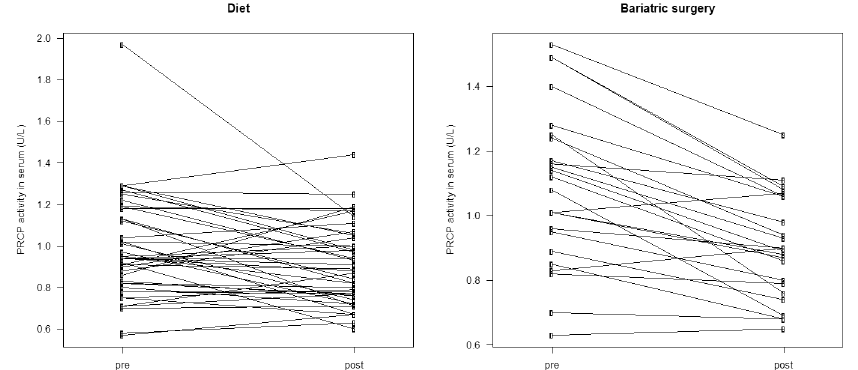
Fig 5. Serum PRCP activity changes after weight loss. Line plots indicating the individual change in PRCP activity in serum of patients who lost weight either by diet (n = 45, p = 0.015) or by bariatric surgery (n = 24, p < 0.001).